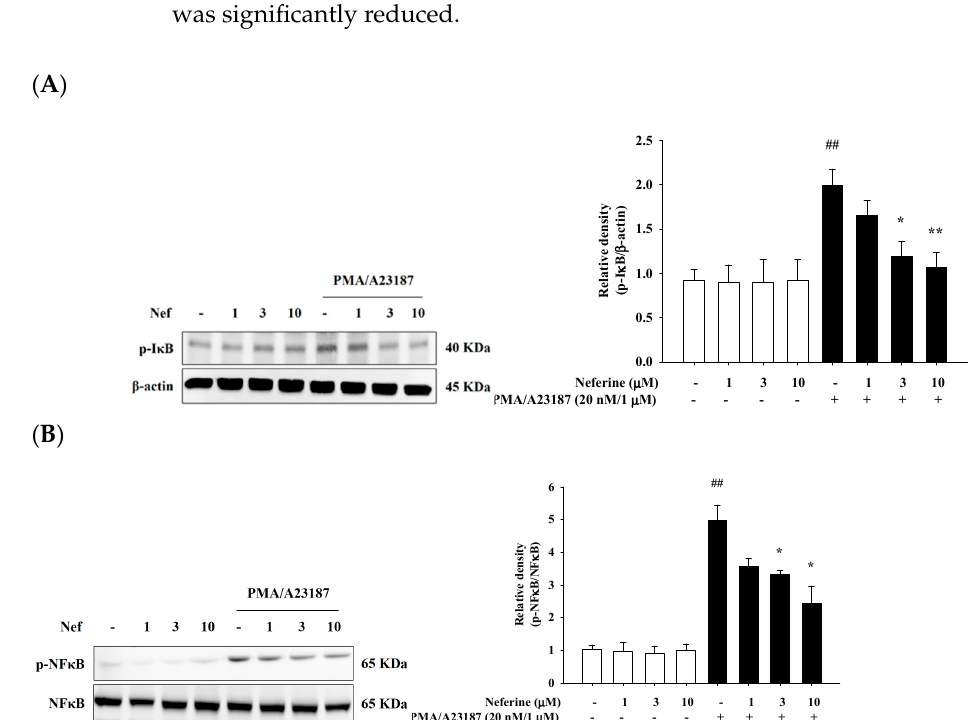
Figure 6. Neferine inhibited PMA/A23187-induced I κ B ( A ) and NF κ B ( B ) activation in HaCaT cells. Cells were pretreated with different concentrations of neferine—1, 3, and 10 μ M—for 20 min and then treated with PMA/A23187 (20 nM/1 μ M) for 30 min. Western blots were analyzed quantitatively. Values represent the mean ± SEM from the three independent experiments. ## p < 0.01 compared with the no-treatment condition, * p < 0.05, ** p < 0.01 compared with the only PMA/A23187 treatment condition.